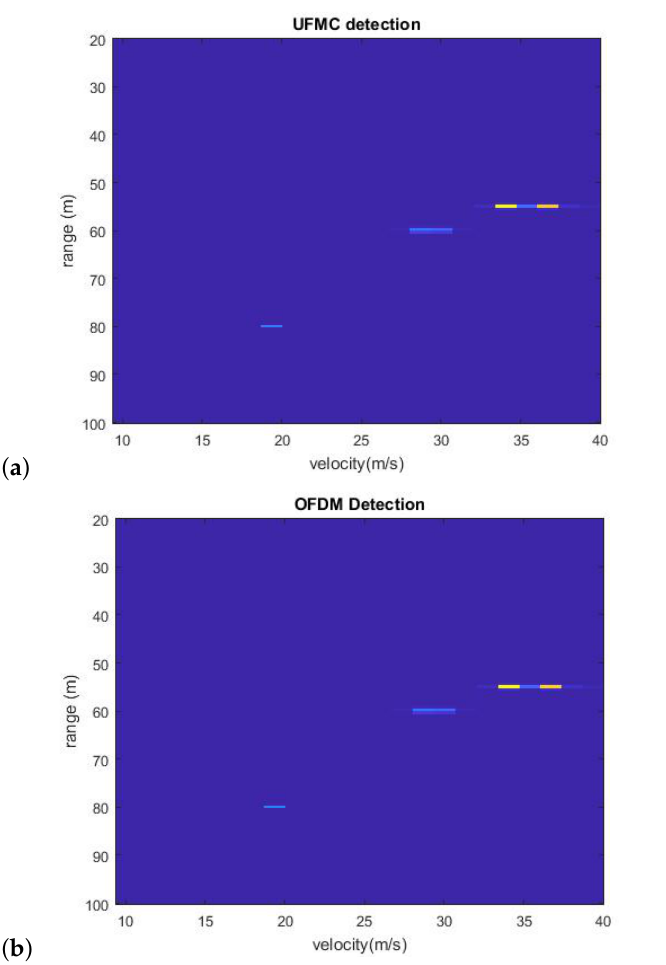
Figure 5. UFMC waveform vs orthogonal frequency division multiplexing (OFDM) waveform: ( a ) UFMC. ( b )